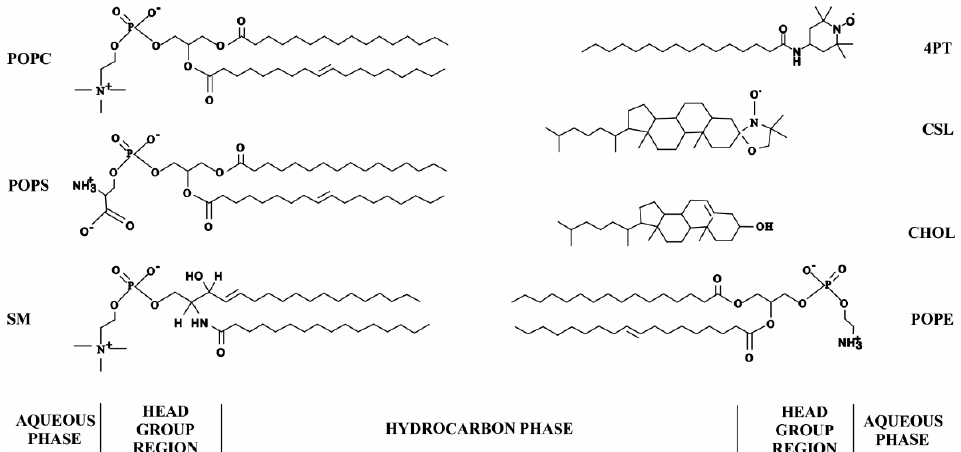
Figure 6. The molecular structure of the major lipids of the eye lens, such as phospholipids (1-palmitoyl-2-oleoyl-sn-glycero-3-phosphatidylcholine (POPC), 1-palmitoyl-2-oleoyl-sn-glycero-3-phosphoethanolamine (POPE) and 1-palmitoyl-2-oleoyl-sn-glycero-3-phosphatidylserine (POPS)), sphingomyelin (SM) and cholesterol (Chol). The molecular structures of spin-labels (cholesterol analog spin-label (CSL) and 4-palmitamido-TEMPO (4PT)) used in this study are also shown. The estimated location of each molecule on the lipid bilayer membrane is displayed. The nitroxide moieties of CSL and 4PT spin ‐ labels reside below the surface of the membrane (below the membrane’s headgroup regions [68,83,89]) and on the surface of the membrane (in the aqueous phase close to the membrane surface [88]), respectively.